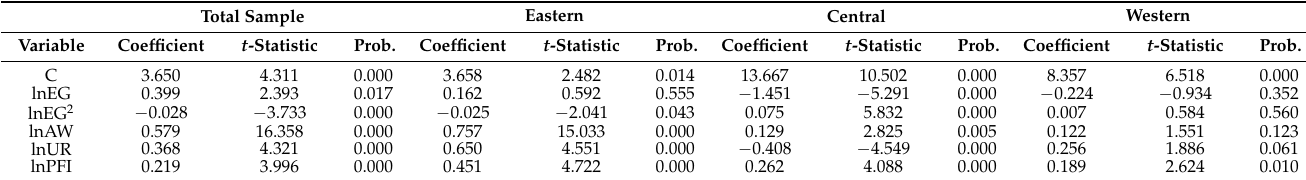
Table 5. Regional long-term regression results used fixed-effects